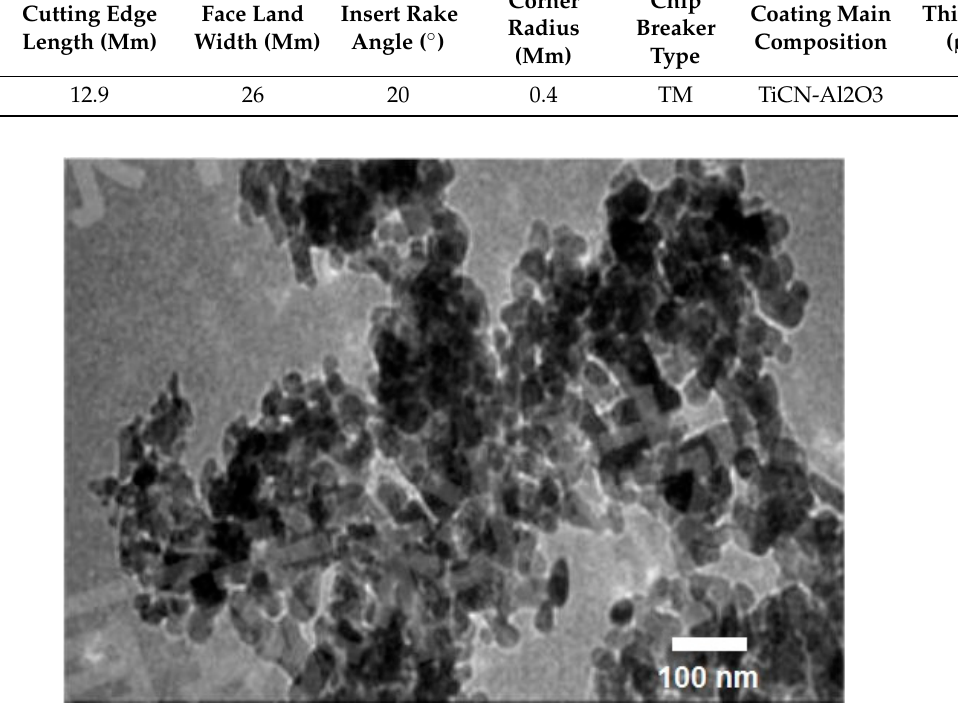
Figure 2. Transmission electron microscopy (TEM) image of Al 2 O 3 nanoparticles. Adapted from [32].